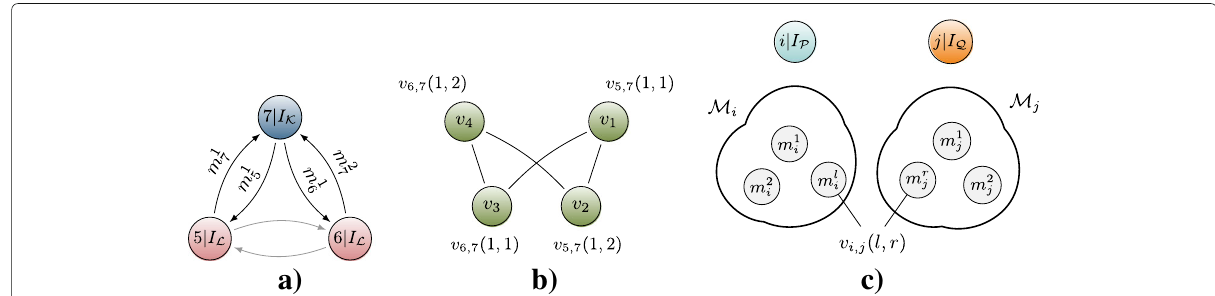
Fig. 3 a Illustration of a network with non-unique identification sequences I K and I L and their respective distance measurements as seen by the receiving node [14]. The gray arrows and their corresponding measurements are not considered in the subproblem between I K and I L . b Ambiguity corresponding to a , where v 5 is given by the pair of measurements indicated in gray between agents “5” and “6.” For clarity, the edges are annotated with the measurements that give rise to them (cf. items 1(a) and 1(b) in the listing in Section 3). Independent of the previous example, c provides a general illustration of how vertices v i , j ( l , r ) are formed based on the measurement sets M i and M j of agents i and j ,